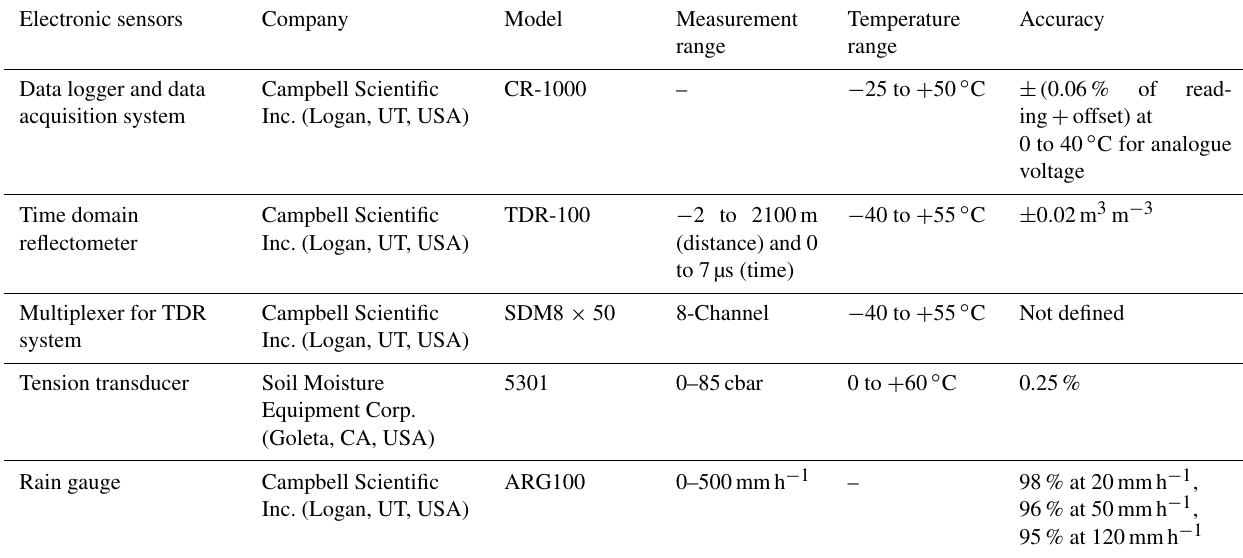
Figure 7. Installed instruments: (a) schematic representation; (b) rain gauge; (c) Jet-fill tensiometer; (d) TDR probe; and (e) data logger case. The main features of the electronic instruments are reported by Table 3. Table 3. Main characteristics of the installed electronic